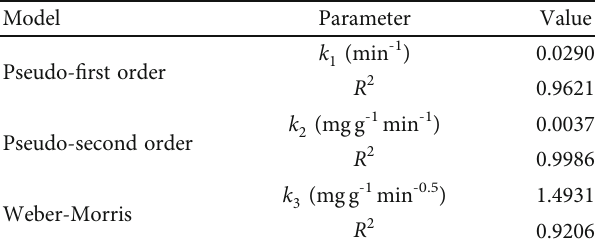
Table 4: Kinetic model parameters for the adsorption of MB onto